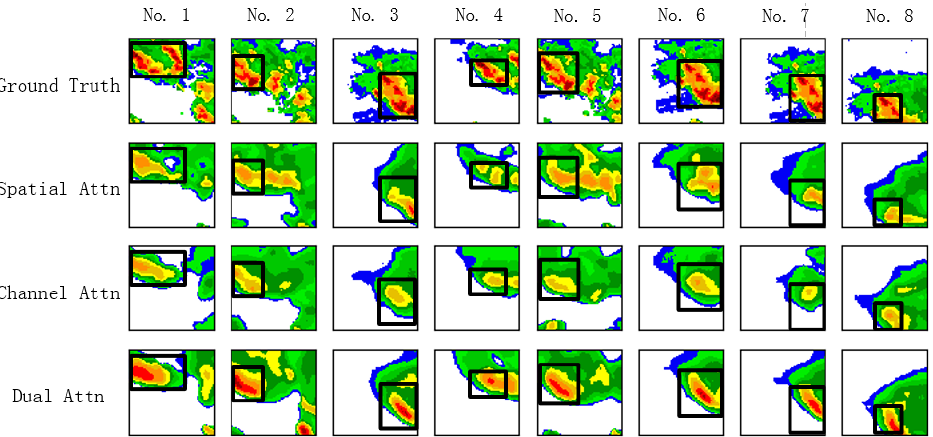
Figure 6. The first line is the eight ground truth examples and the rest are predictions after an hour merely with spatial attention (second row), channel attention (third row), and dual attention (the last row). (Best view in